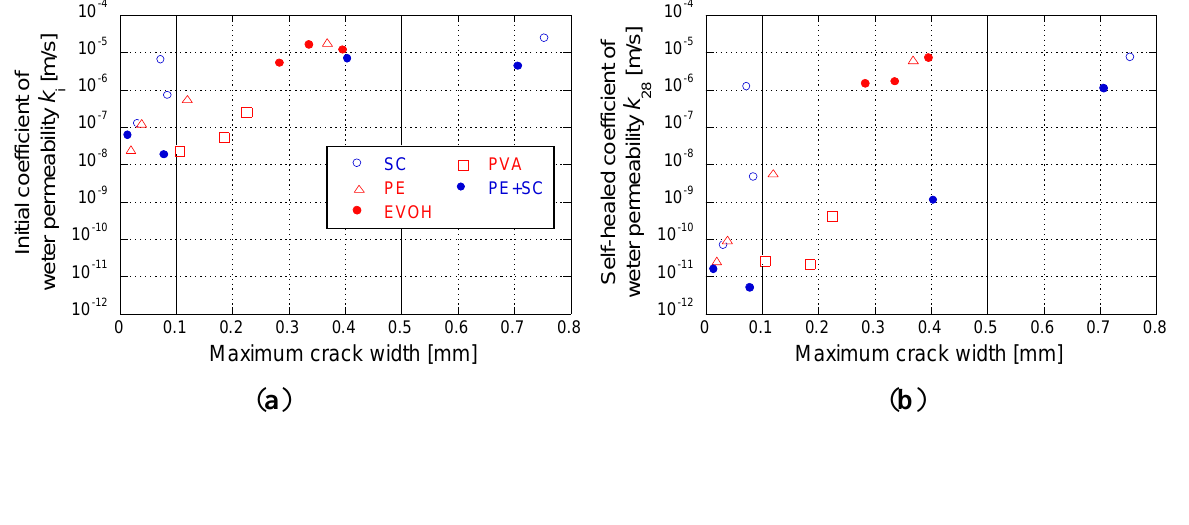
Figure 7. Relationship between the maximum crack width and coefficients of water permeability: ( a ) initial and ( b ) after